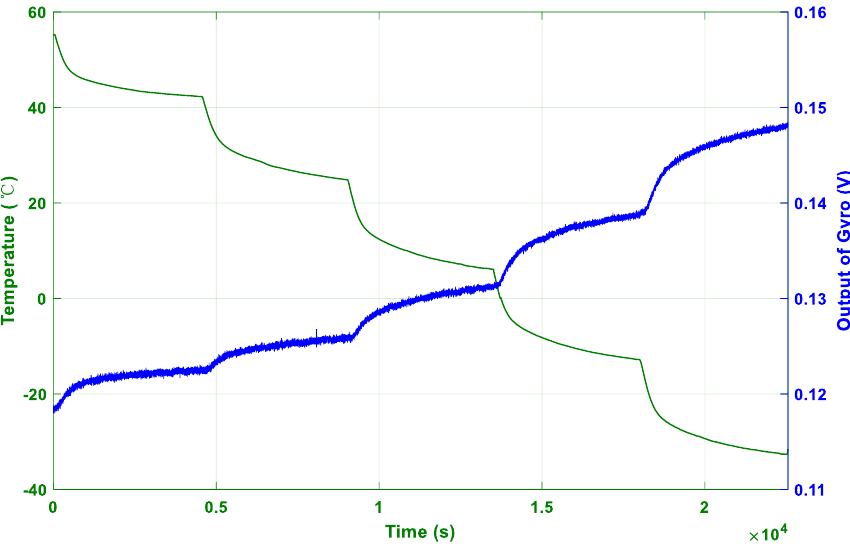
Figure 10. Temperature and gyroscope output data obtained from temperature experiments.